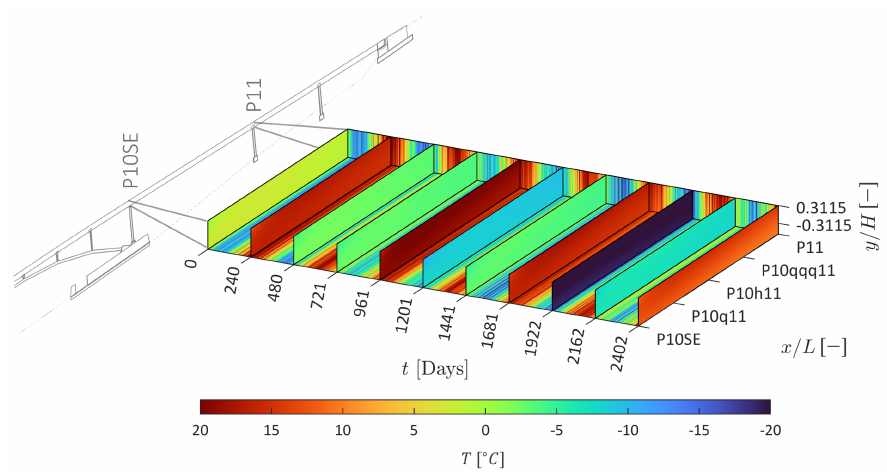
Figure 7. Predicted temperature